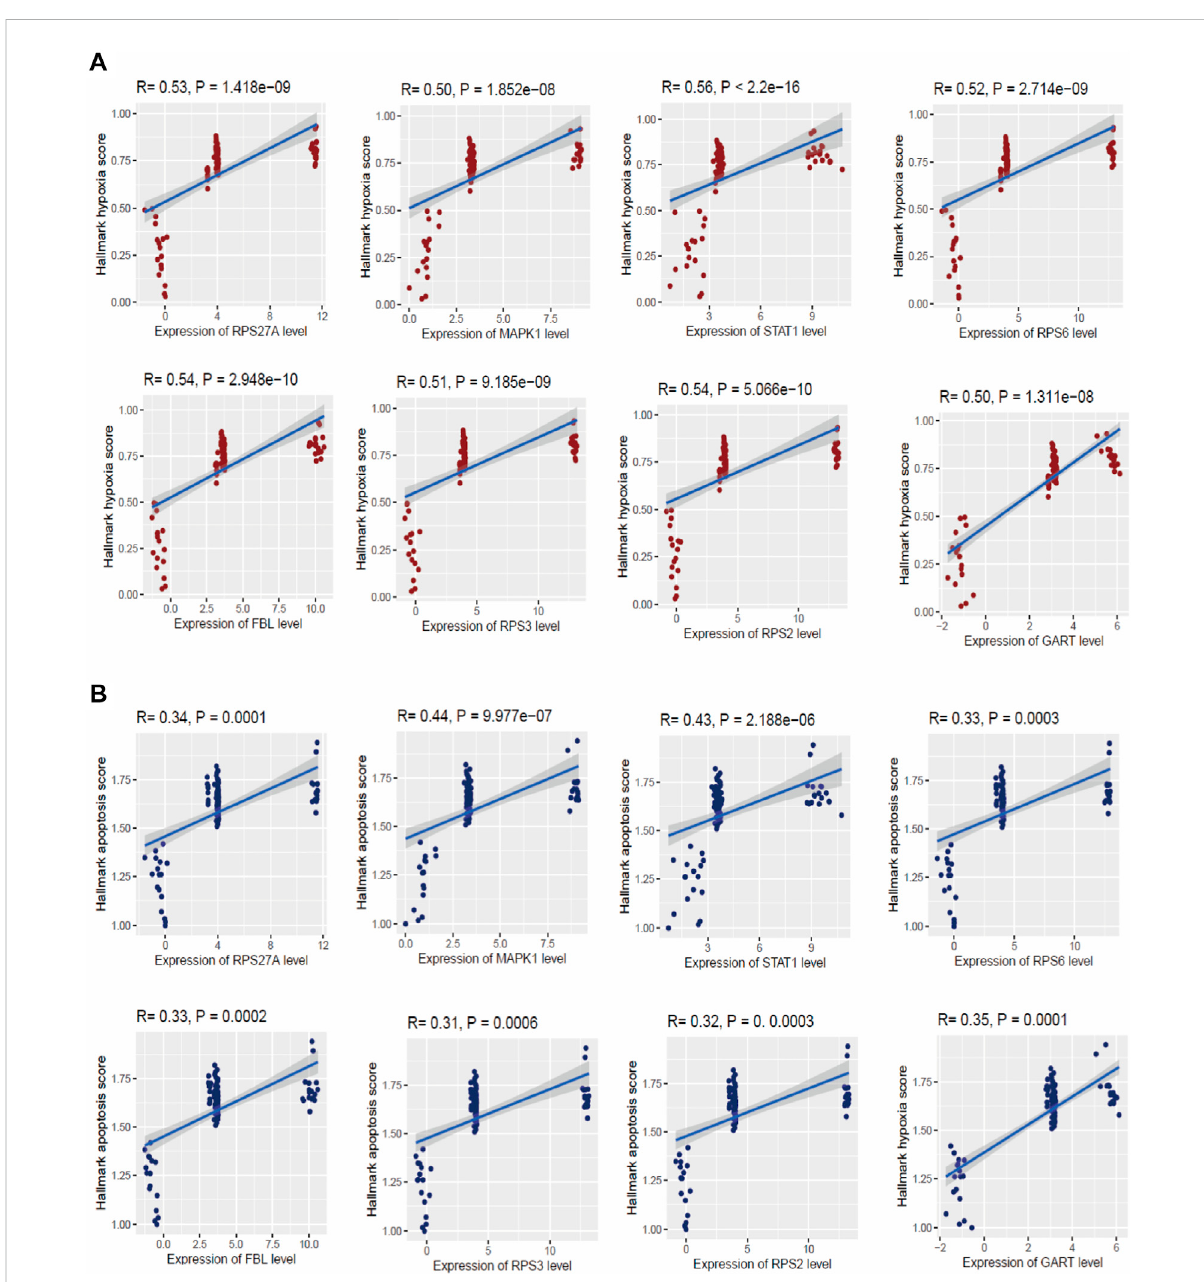
FIGURE 7 The expression levels of hub genes are signi fi cantly correlated with ssGSEA scores of hallmark hypoxia (A) and apoptosis (B) gene set in PAH (Spearman ’ s correlation test, p < 0.05). The hallmark gene set of hypoxia and apoptosis was downloaded from the GSEA (http://www.gsea-msigdb.